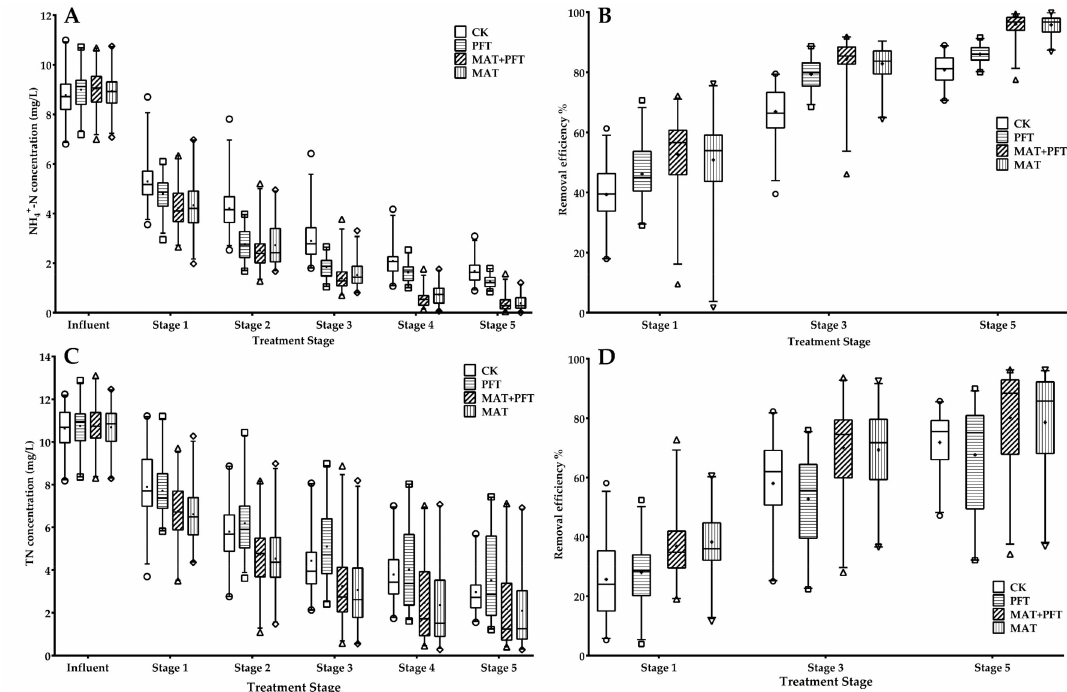
Figure 5. Changes of NH 4+ ( A ) and TN concentrations ( C ) as well as removal efficiencies of NH 4+ ( B ) and TN ( D ) in the PSCW. CK, PFT, MAT, and MAT with PFT represent the control and PSCW treatments with polyethylene fiber, M . aquaticum , and M . aquaticum with polyethylene fiber, respectively. Black solid lines and plus signs represent the median and mean of the datasets, respectively. The bottom and top edges of the box plots indicate the 25th and 75th percentiles, and the whiskers illustrate the 2.5th and 97.5th